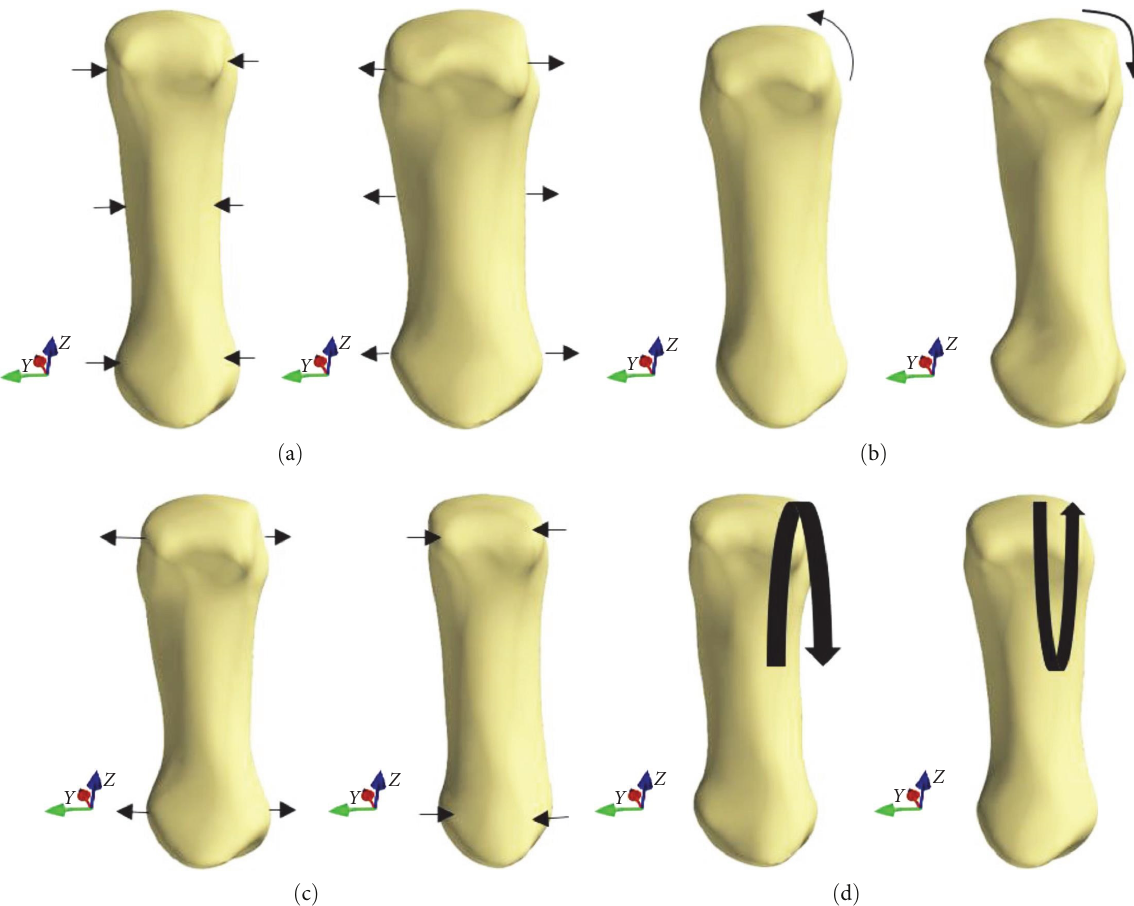
F IGURE 5: Principal components of the fi rst metacarpal bone with nrSSM from − 2SD model to + 2SD model: (a) represents the fi rst principal component; (b) represents the second principal component; (c) represents the third principal component; (d) represents the fourth principal component.